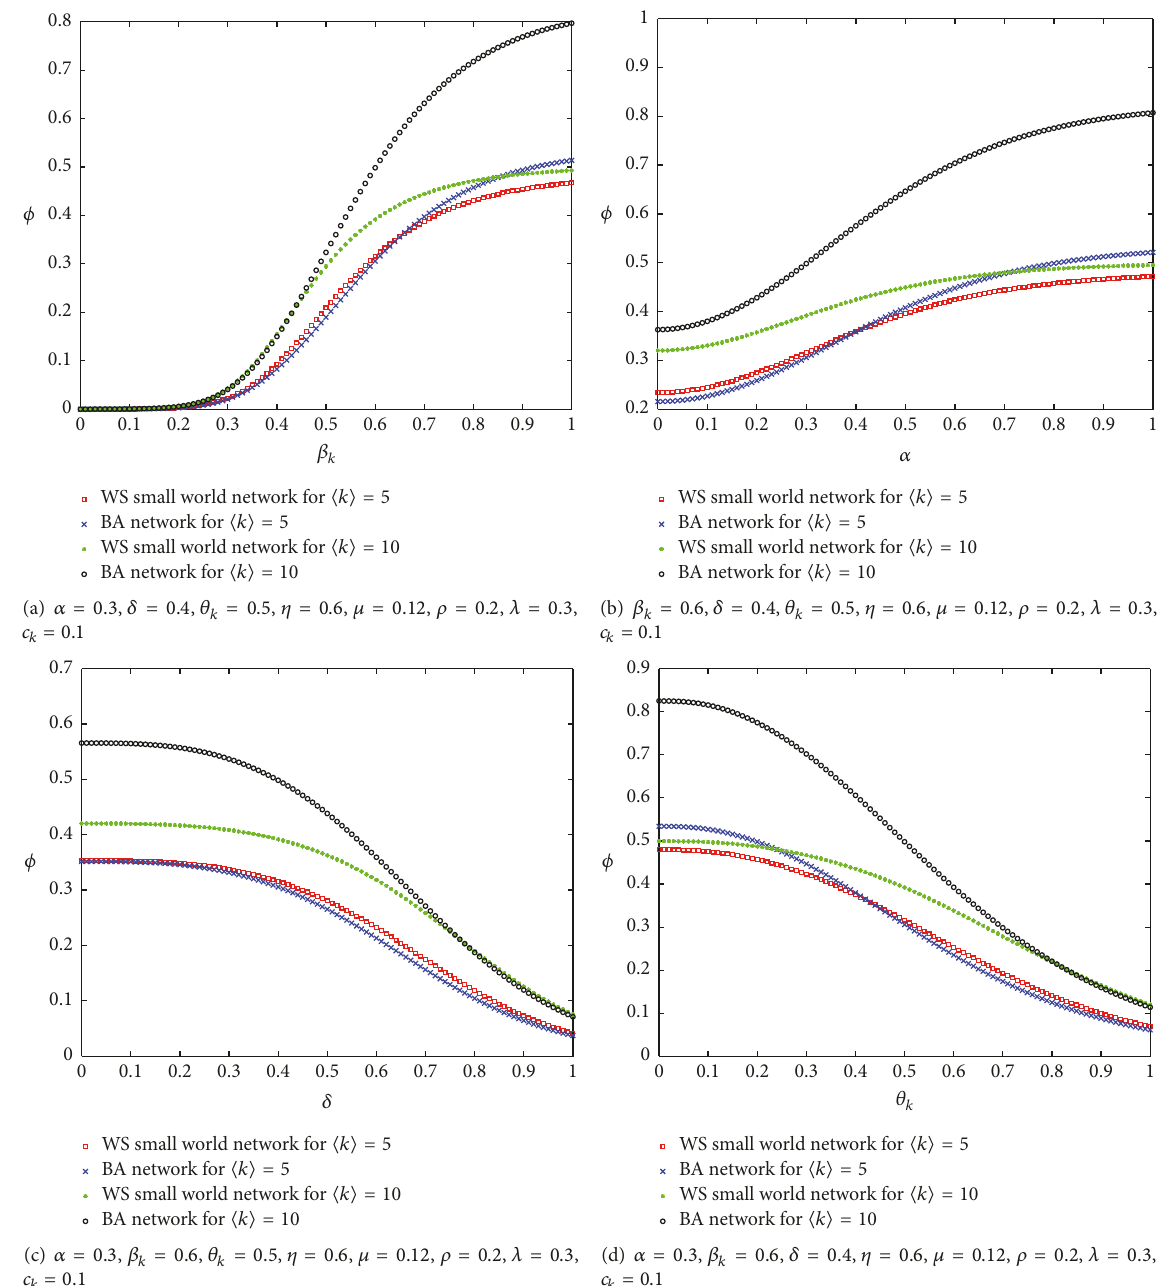
Figure 5: The evolution function of the contagious scale 𝜙 of credit risk as function in the risk preference level 𝛽 𝑘 of investors, the effect degree 𝛼 of market noises, the supervision strength 𝛿 of financial market regulators, and the resistance 𝜃 for 𝛼 = 0.3 , 𝛿 = 0.4 , 𝜃 = 0.5 , 𝜂 = 0.6 , 𝜇 = 0.12 , 𝜌 = 0.2 , 𝜆 = 0.3 , 𝑐 𝑘 = 0.1 ; (b) for 𝛽 𝑘 = 0.6 , 𝛿 = 0.4 , 𝜃 = 0.5 , 𝜂 = 0.6 , 𝜇 = 0.12 , 𝜌 = 0.2 , 𝜆 = 0.3 , 𝑐 = 0.1 ; (c) for 𝛼 = 0.3 , 𝛽 = 0.6 , 𝜃 = 0.5 , 𝜂 = 0.6 , 𝜇 = 0.12 , 𝜌 = 0.2 , 𝜆 = 0.3 , 𝑐 𝑘 𝑘 𝜌 = 0.2 , 𝜆 = 0.3 , 𝑐 = 0.1 𝑘